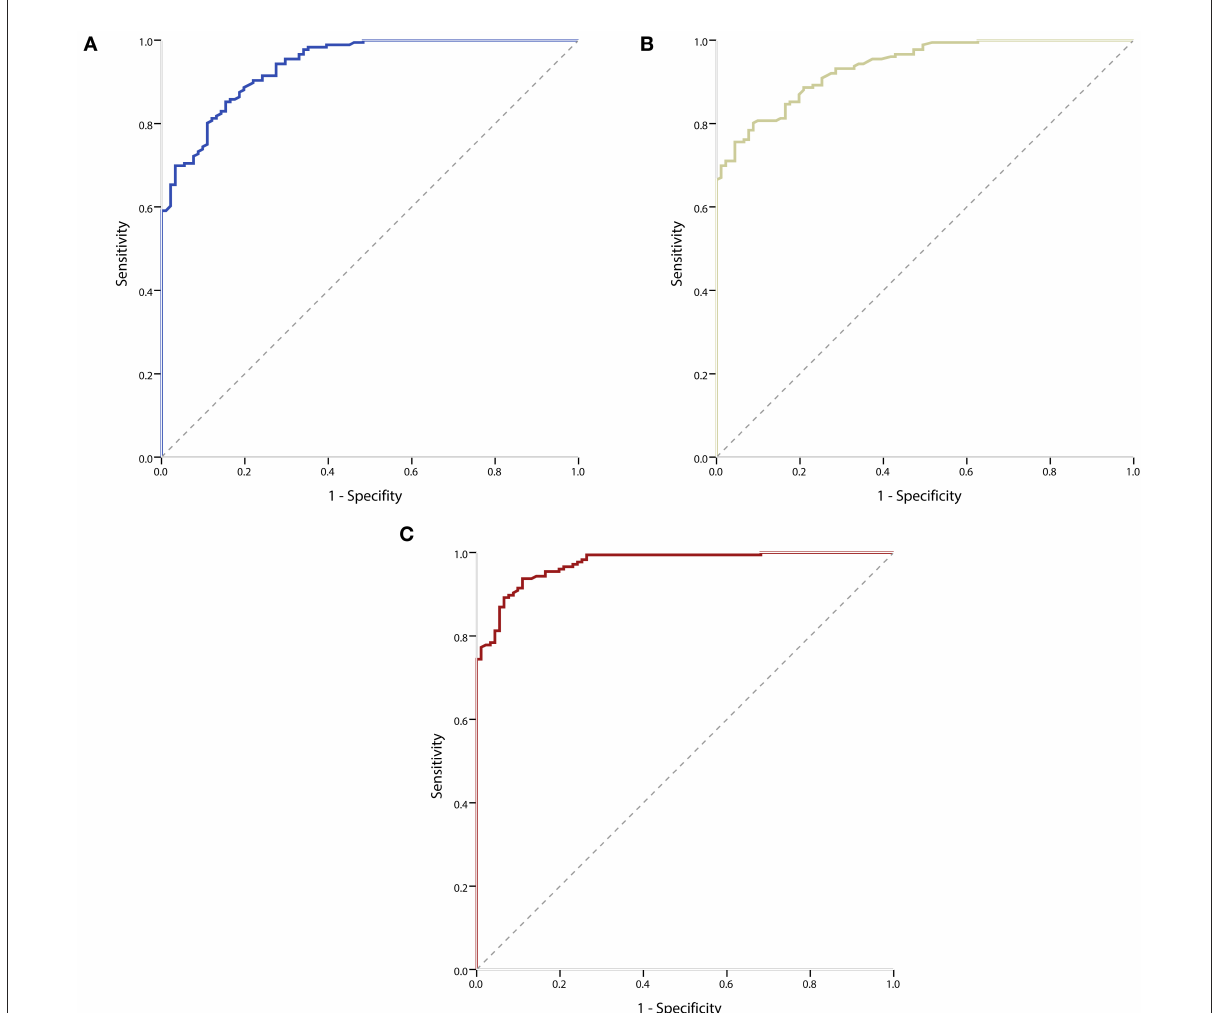
FIGURE2 Receiver operating characteristic (ROC) curves of inflammatory markers to distinguish obese children with or without NAFLD. (A) ROC curve of IL-1 β to distinguish obese children with or without NAFLD. (B) ROC curve of IL-6 to distinguish obese children with or without NAFLD. (C) ROC curve of IL-17 to distinguish obese children with or without